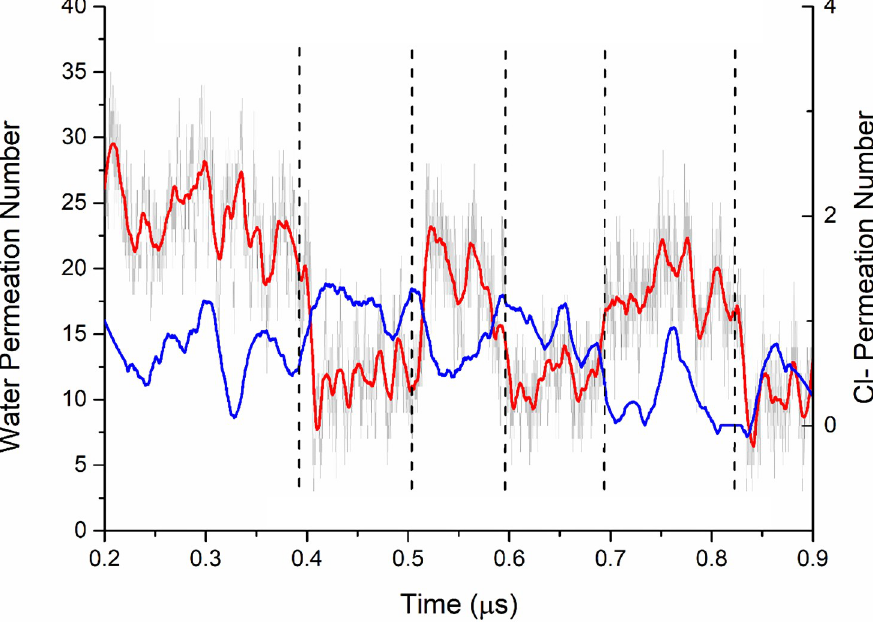
Fig 5. The change in ORF1 with water and chloride ions during the 1 μ s simulation. The gray curve represents the absolute quantity of water molecules. The red and blue curves represent the smooth line of water and Cl - , respectively (200